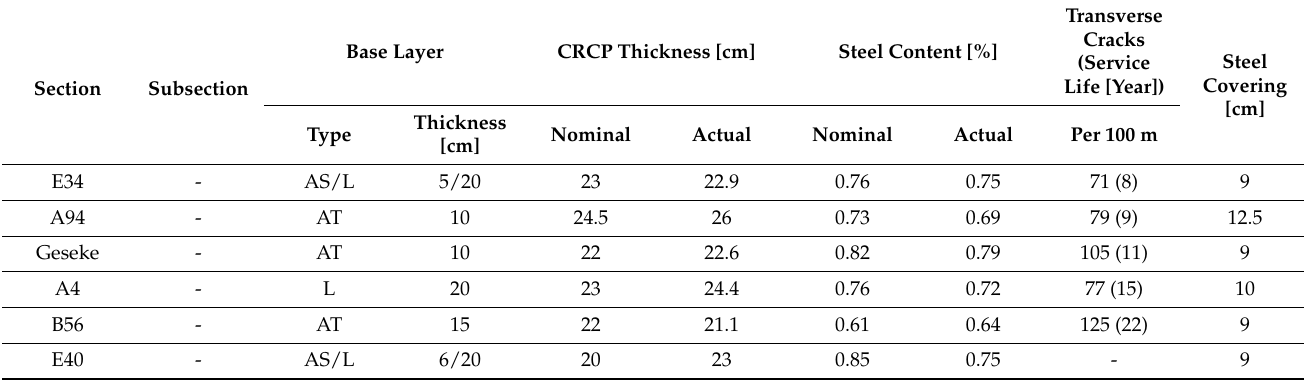
Figure 3 summarizes the categorization of crack spacing into three classes: less than